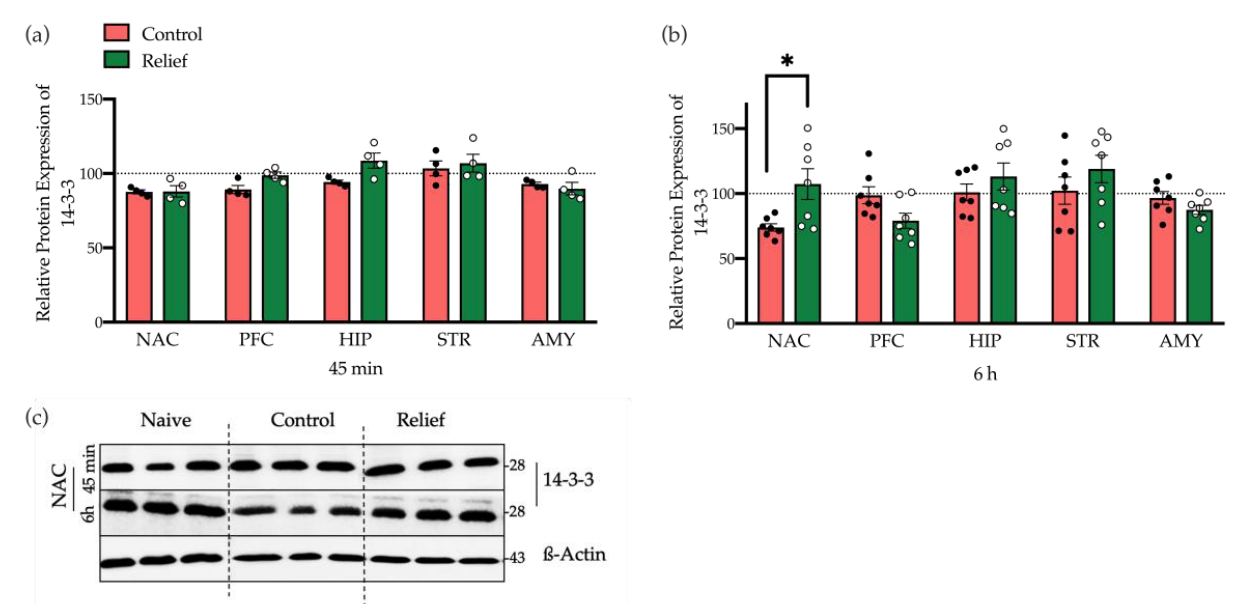
Figure 6. The expression level of 14-3-3 protein. ( a )The expression level of 14-3-3 was not affected 45 min after relief conditioning in any regions of study. ( b ) 6 h after conditioning the expression level of 14-3-3 in NAC was significantly higher than the control group, while in the other regions no difference was seen. Bar diagrams depict the mean ± SEM ( n = 4–7/group; * p ≤ 0.05). ( c ) Representative Western blot, showing the expression levels of 14-3-3, 45 min and 6 h following control or relief conditioning in NAC (3 different biological samples/group).